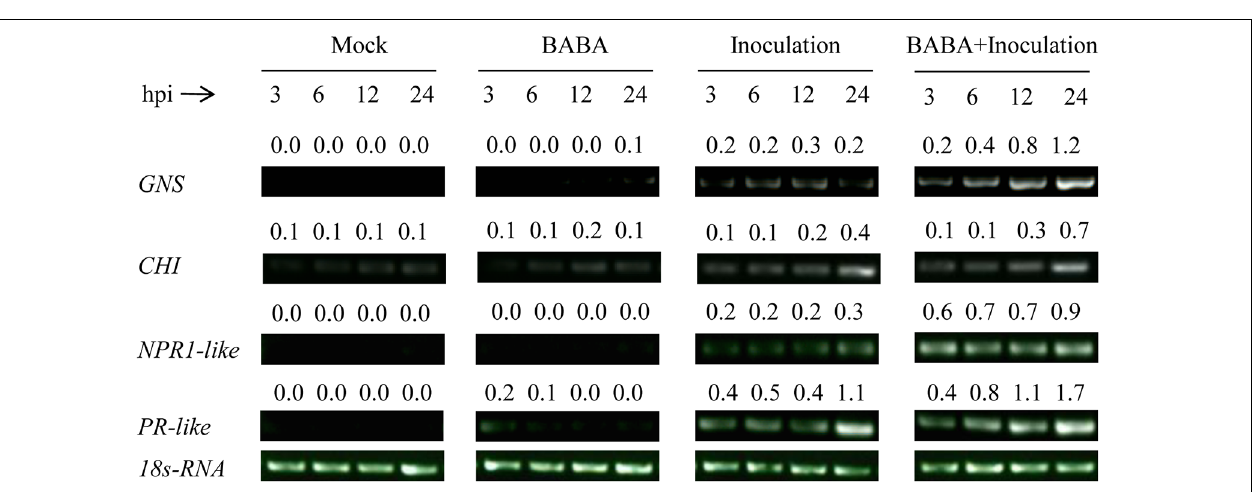
FIGURE 6 | Changes in expression levels of the defense related genes β -1,3-glucanase ( GNS ), chitinase ( CHI ), non-expressor of pathogenesis-related protein1 ( NPR1-like ), and pathogenesis-related protein ( PR-like ) in peach fruit after inoculation with sterile distilled water (Mock), Rhizopus stolonifer (Inoculation), 50 mM BABA (BABA), or with 50 mM BABA and inoculated with R. stolonifer (BABA + Inoculation) during storage at 20 ◦ C. Semiquantitative reverse transcription-polymerase chain reaction (RT-PCR) was conducted using 18S-rRNA as the internal control. hpi, hours